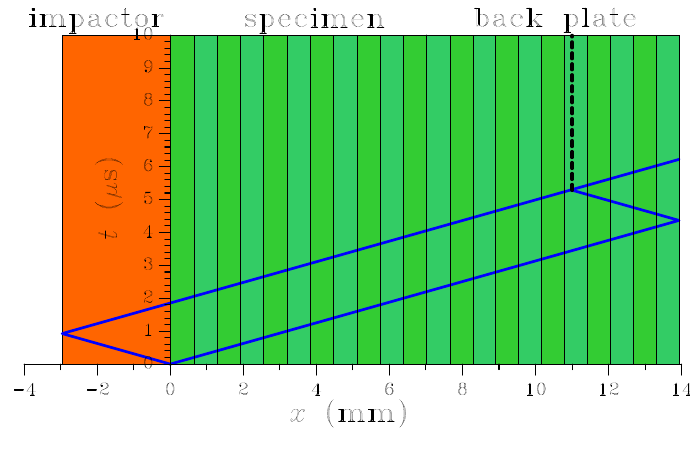
Figure 7. Impact on a 11+11-layer composite [14]: space-time diagram (the vertical dashed line here represents the possibly debonding surface of a brittle, homogeneous